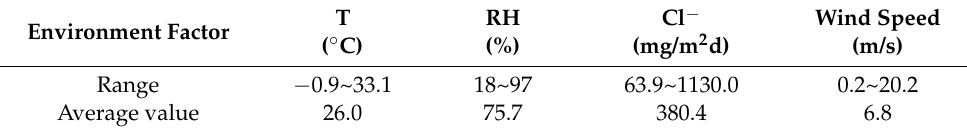
Table 3. The range and average value of environment factors during ocean voyage.